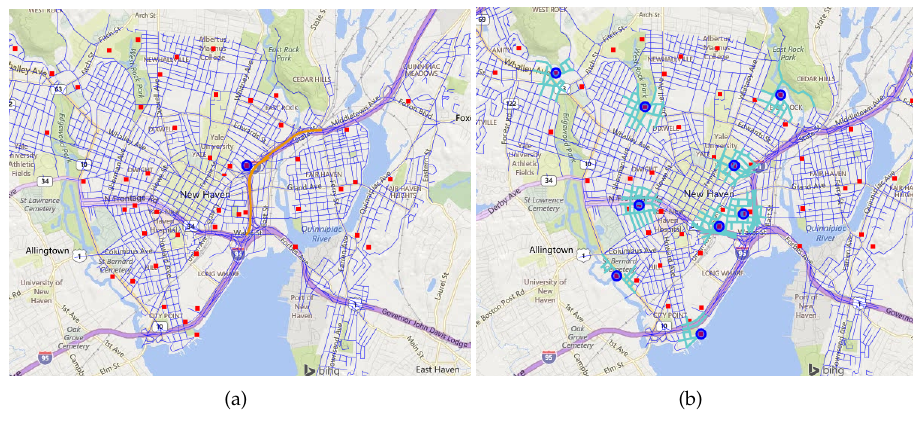
Figure 4. ( a ) Interstate near middle school and ( b ) streets near high